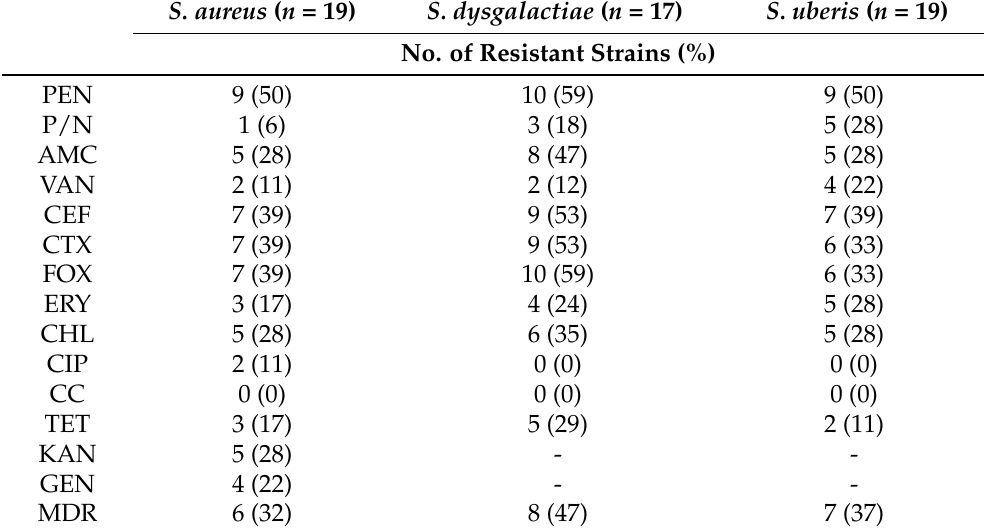
Antibiotic resistance profile of Staphylococcus aureus, Streptococcus dysgalactiae and Streptococcus uberis isolated from clinical bovine